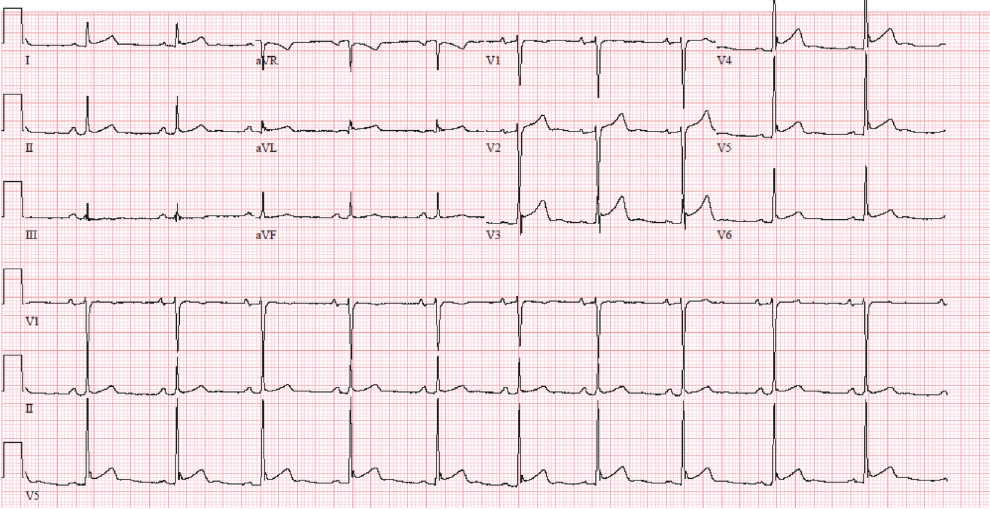
Figure 3: ECG prior to the surgery showing ST segment elevation in leads V3-V6.